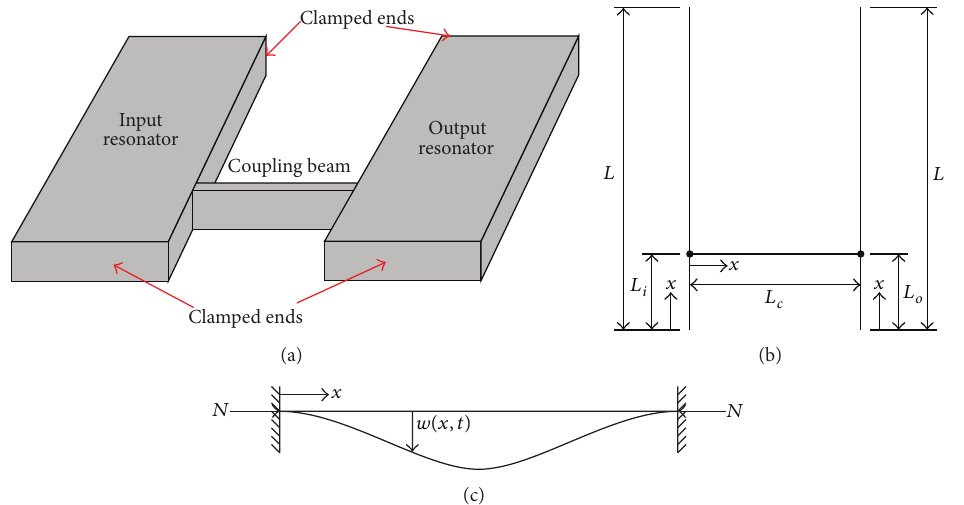
Figure 1: (a) A schematic drawing and (b) a schematic model of a filter made of two clamped-clamped microbeam resonators coupled by a weak beam and (c) a schematic diagram for one of the primary